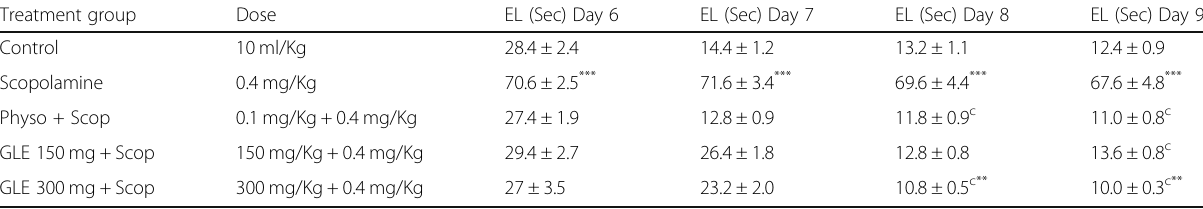
Table 1 Effect of Ganoderma lucidum on Escape Latency (sec) in Morris Water Maze Treatment group